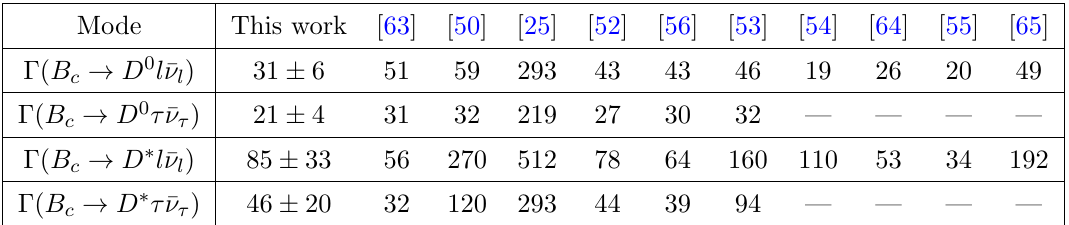
Table 5 . Decay widths of B c ! D 0 ; (cid:3) decays, given in 10 (cid:0) 18 GeV using the PDG average value of V ub from eq.